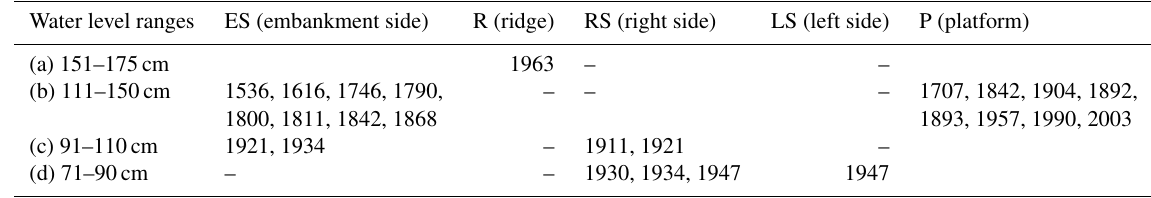
Table 3. Division of HS3 stone and list of marks by ranges. Water level ranges